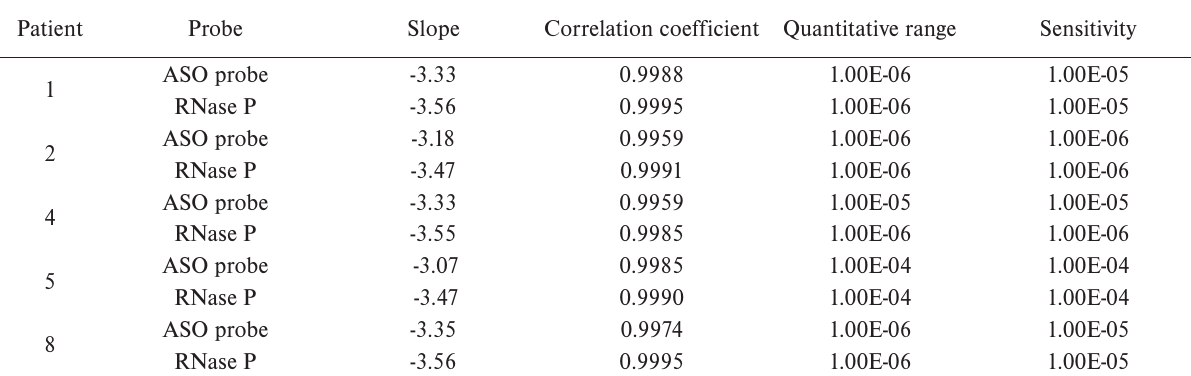
Table S2. Standard curves parameters for RQ-PCR detection of tumor-specific marker in MM.